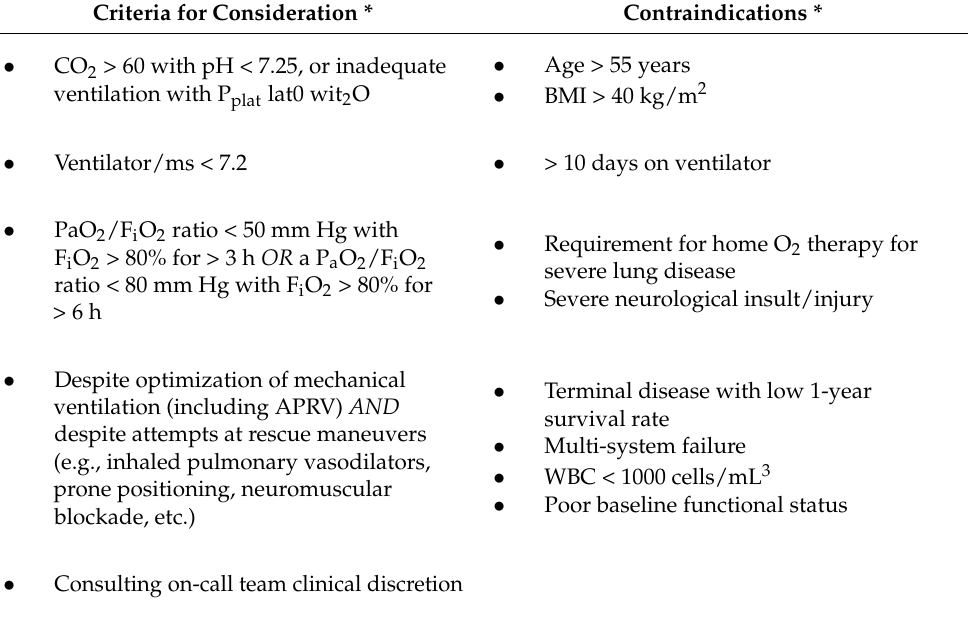
Table 1. The criteria for veno-venous extracorporeal membrane oxygenation in COVID-19. Criteria for Consideration